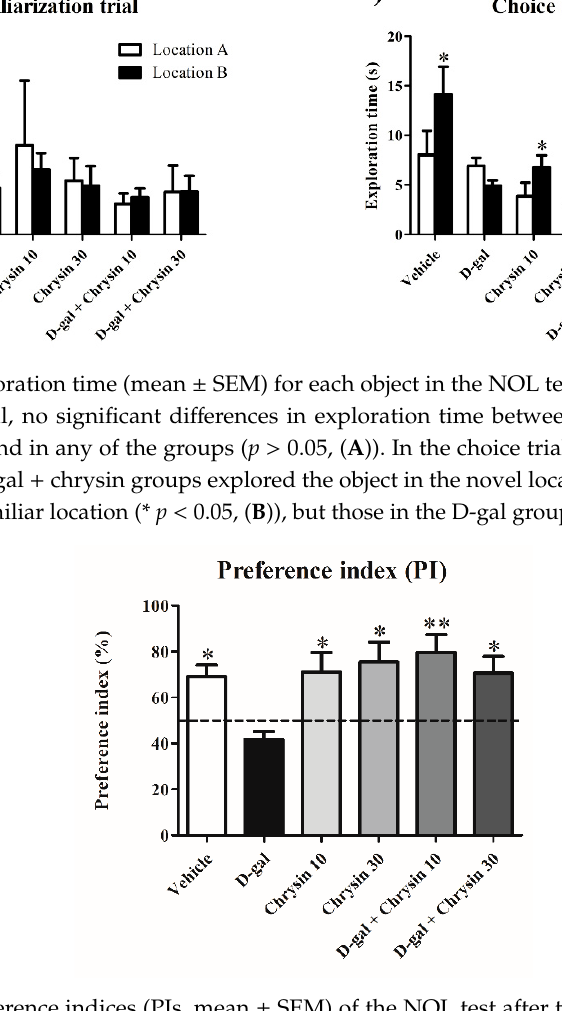
Figure 2. The preference indices (PIs, mean ± SEM) of the NOL test after treatment. The PIs of the vehicle, chrysin 10, chrysin 30, and D-gal + chrysin groups differed significantly from 50% chance (* p < 0.05, ** p < 0.01), but that in the D-gal group did not ( p > 0.05).